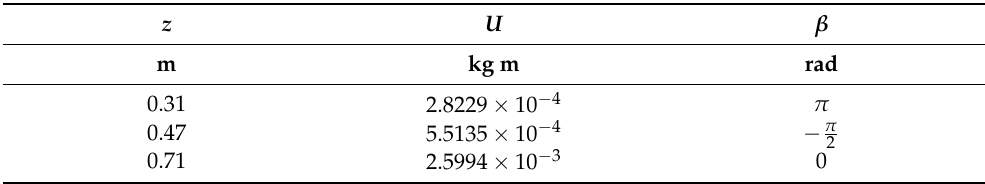
Table 5. Balancing weights of case